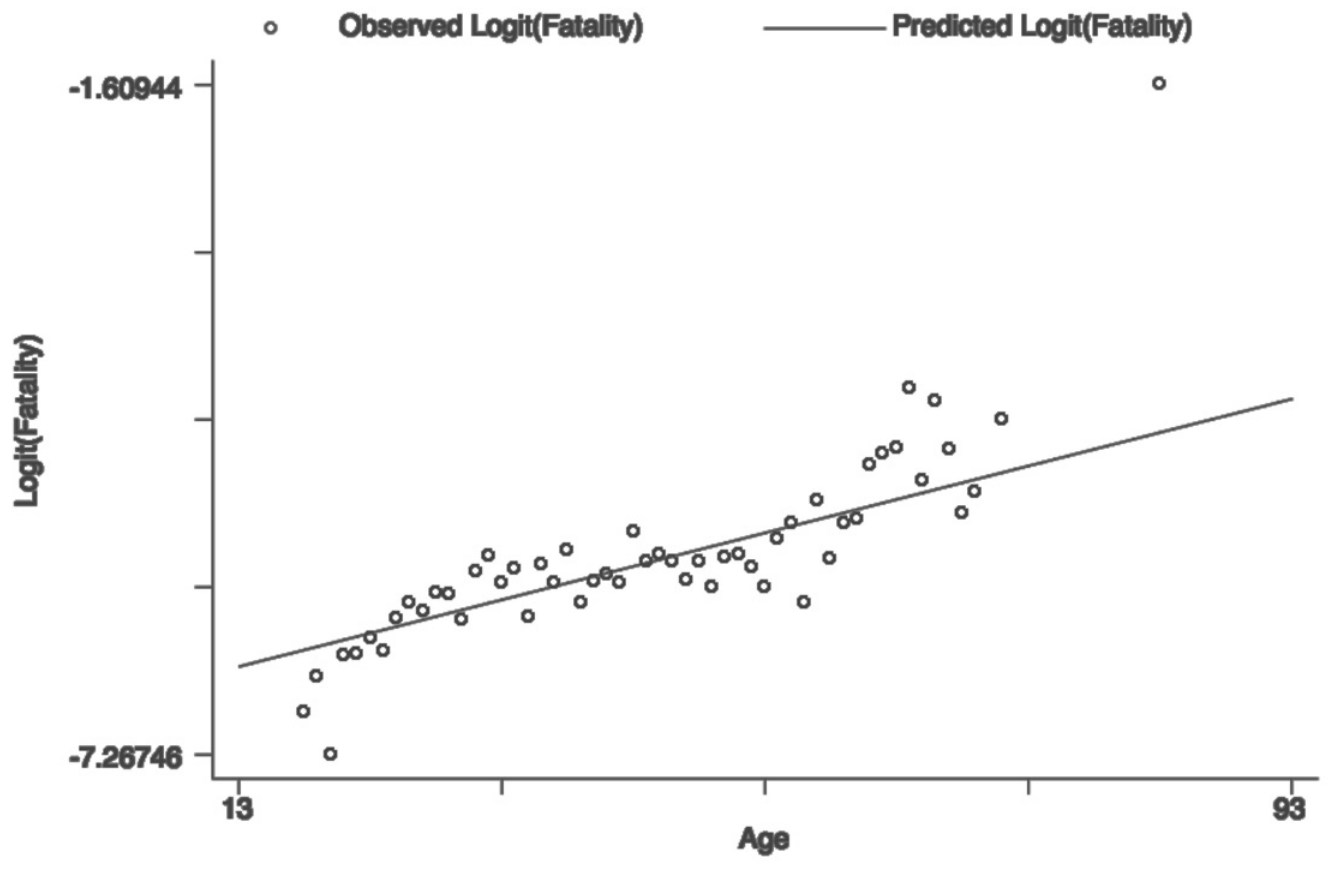
Fig 2. Relation between the logit of fatality versus continuous